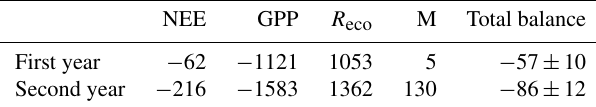
Table 2. The annual carbon balances and their components (gCm − 2 yr − 1 ) for the 2 measurement years. Negative values in- dicate C input into the ecosystem, whereas positive values indicate C loss. Management (M) is the sum of the C fluxes due to harvest (positive) and fertilization (negative) events (Table 1). The values after ± represent the uncertainty in NEE. NEE GPP R eco M Total balance First year − 62 − 1121 1053 5 − 57 ± 10 Second year − 216 − 1583 1362 130 − 86 ± 12